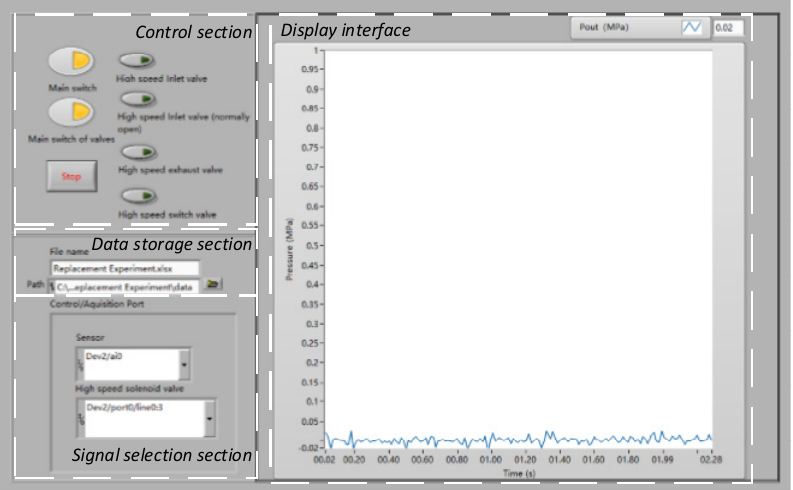
Figure 4. Software interface of the test bench for the pressure regulation characteristics of the APRV of different structural configurations in the ECPBS of commercial vehicles.